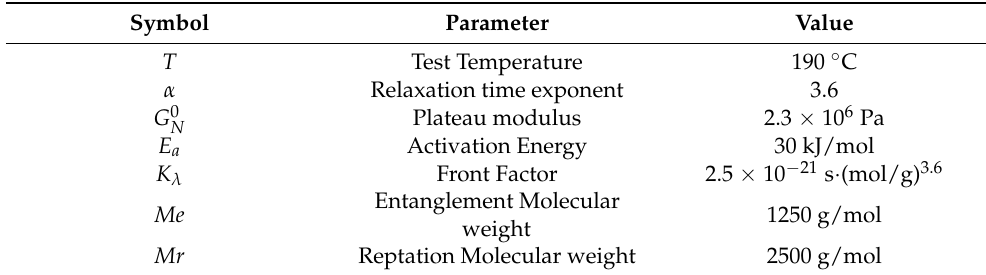
Parameters used for the molecular weight distribution calculation from inverse rheology